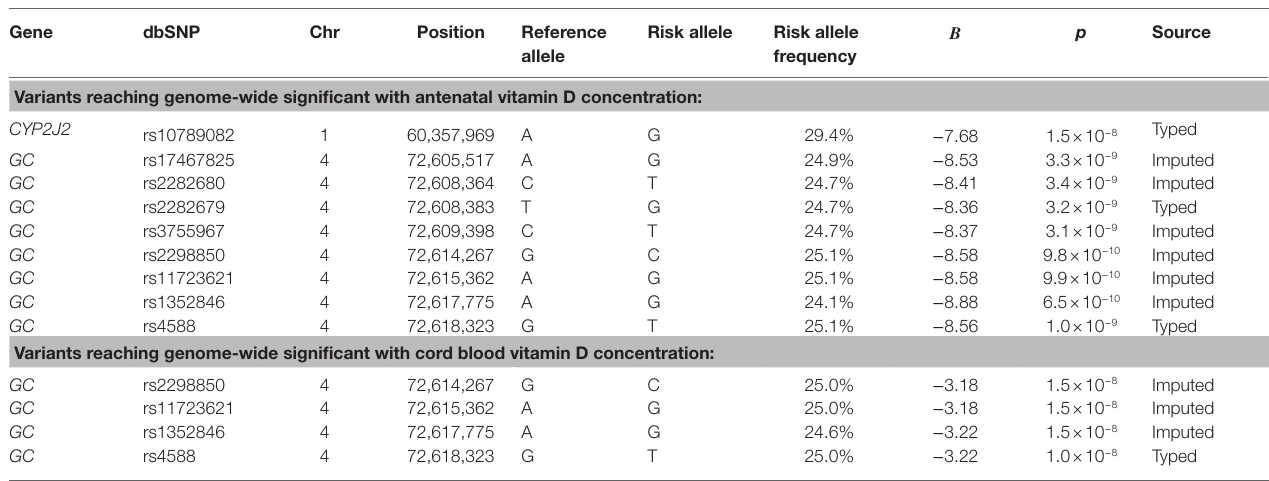
TABLE 3 | Variants reaching genome-wide significance.